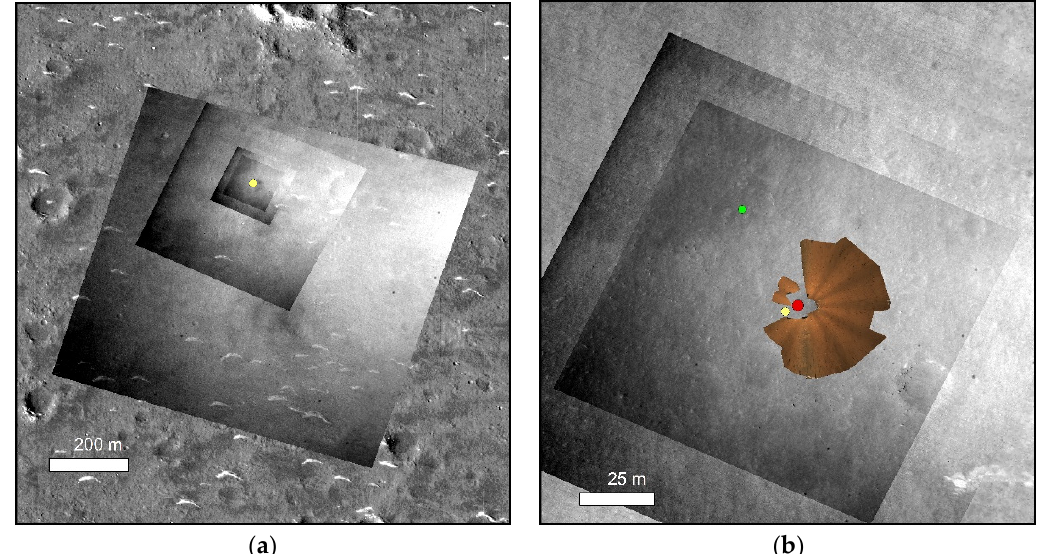
Figure 7. The localization results based on image matching methods: ( a ) shows the results of image matching among the sequential descent images and the HiRIC DOM; ( b ) shows the triangulation, descent image matching and NaTeCam DOM matching based localization results, which are represented as the green, yellow and red points.